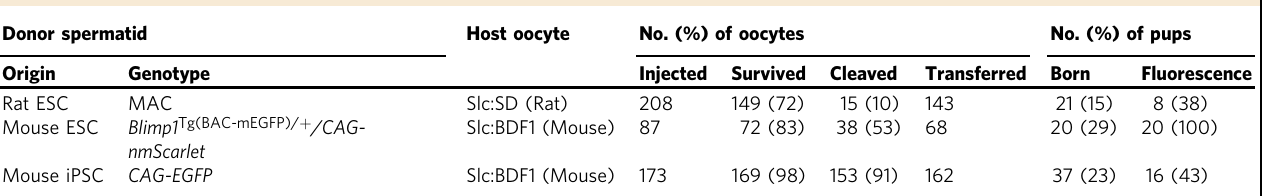
Table 2 Injection of ESC-derived round spermatids into oocytes. Donor